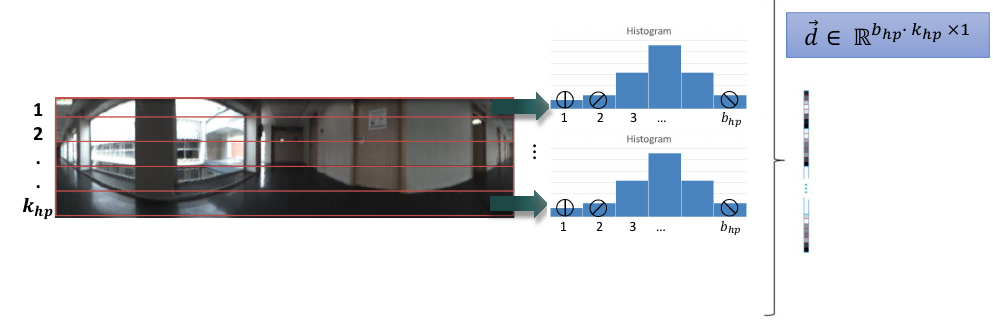
Figure 2. Process to build the HOG descriptor using horizontal